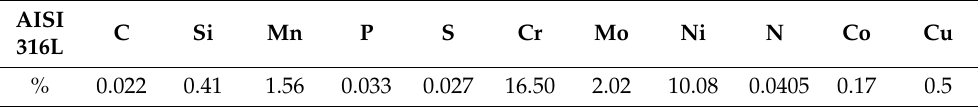
Table 1. Chemical composition of AISI